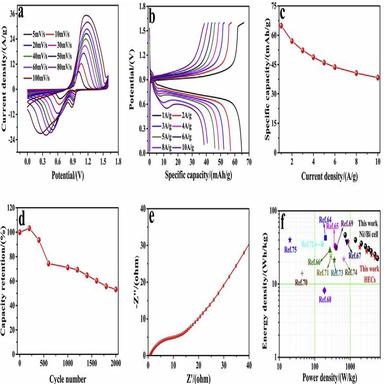
Electrochemical behaviors of the Ni//Bi battery: CV curves at different scan rates (a); GCD curves at different current densities (b); Specific capacity at different current densities (c); Cycling performance at 6 A/g (d); Electrochemical impedance spectra (e); Ragone plot (f).